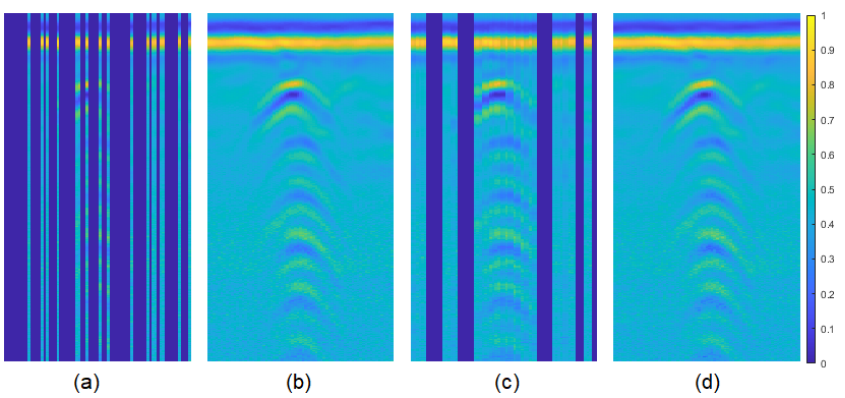
Figure 24. 80% column-wise missing data case for the zoomed third target of real data-II: ( a ) GPR im- age with missing entries, ( b ) original GPR image, recovered images by ( c ) NNM zoomed , ( d ) DIP zoomed . Table 7. PNSR comparison of data recovery methods for column-wise missing case for real data-II. Missing Rate